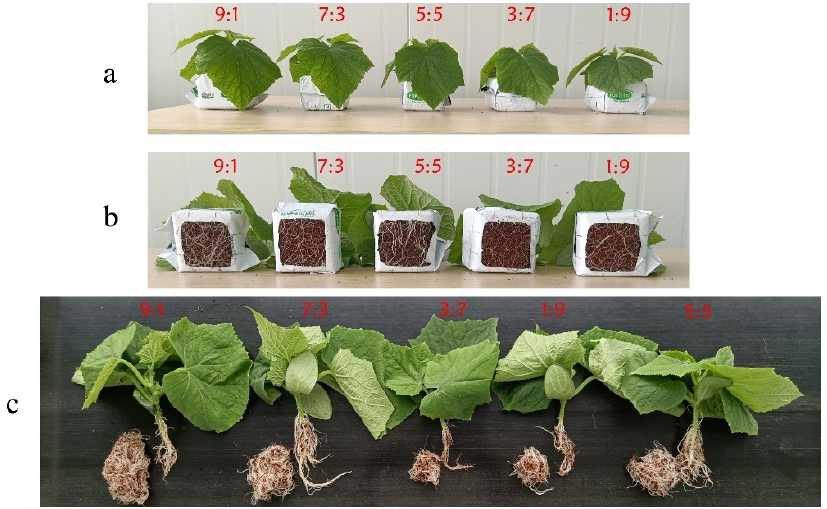
Figure 4. ( a ) Front view of seedlings under different light qualities. ( b ) Root system diagram of the seedling bottom under different light qualities. ( c ) Shape of seedling root after cleaning coconut bran (19-day-old seedling; the ratio indicated in the figure is the red–blue light ratio).